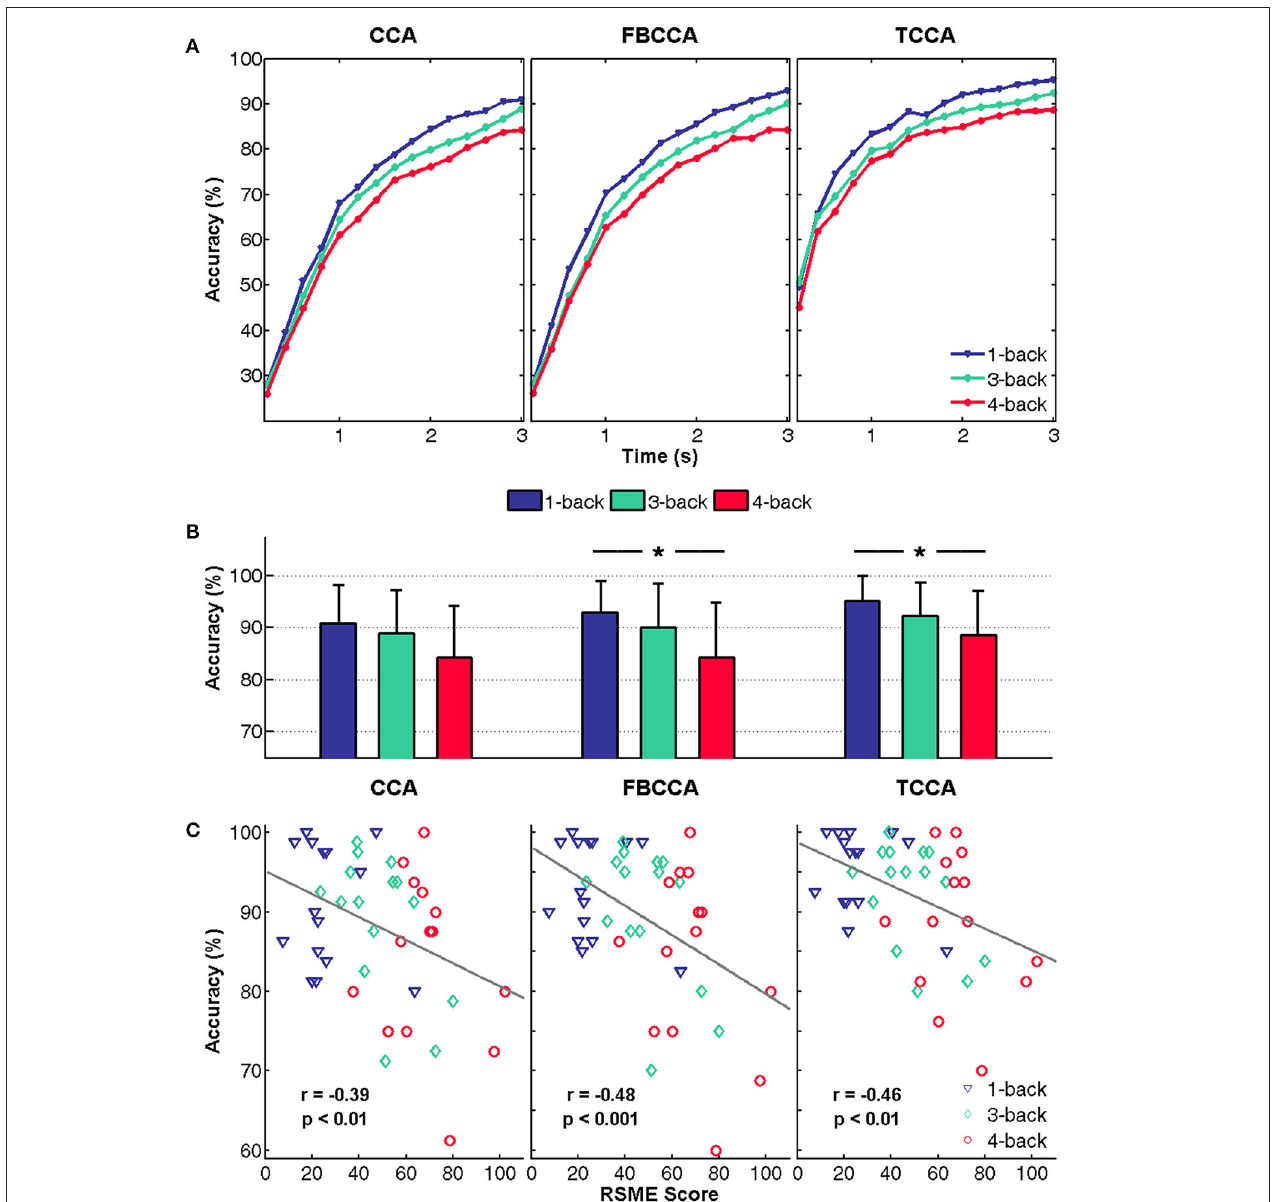
FIGURE 3 | BCI classification accuracy. (A) Mean classification accuracies with various data lengths (from 0.2 to 3s in steps of 0.2s) for the 1-, 3-, and 4-back tasks. (B) Mean classification accuracy with a data length of 3s. The error bars represent standard deviations across subjects and asterisks represent significant differences between two n-back tasks (* p < 0.05). (C) Correlation analysis between RSME score and accuracy with a data length of